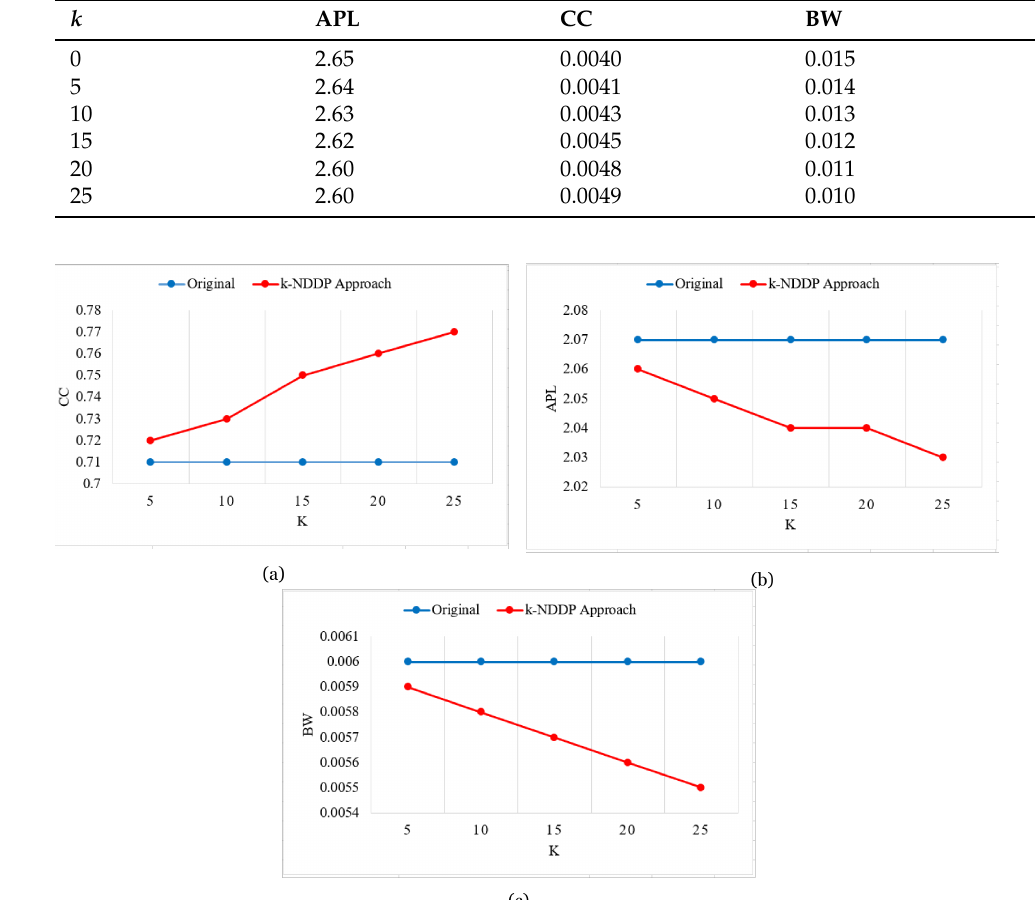
Table 3. Properties of k -NDDP anonymized social network dataset (FEATHER-LASTFM-SOCIAL).